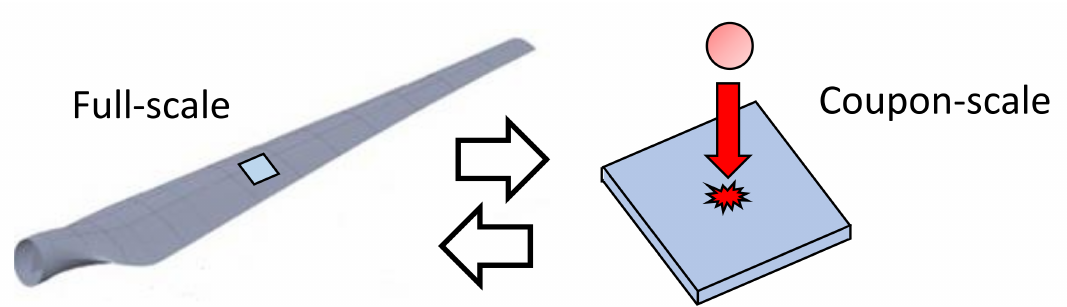
Figure 1. Scale of investigation for impact in wind turbine